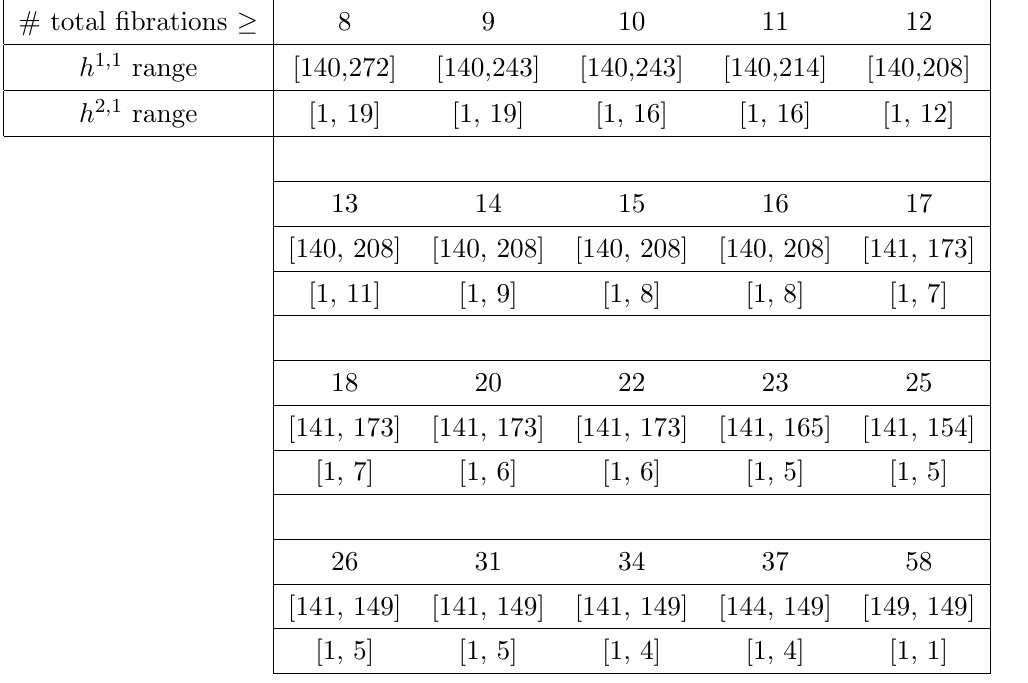
Table 4 . Ranges of Hodge numbers in which the polytopes with the largest numbers of (cid:12)brations (not including automorphisms) are